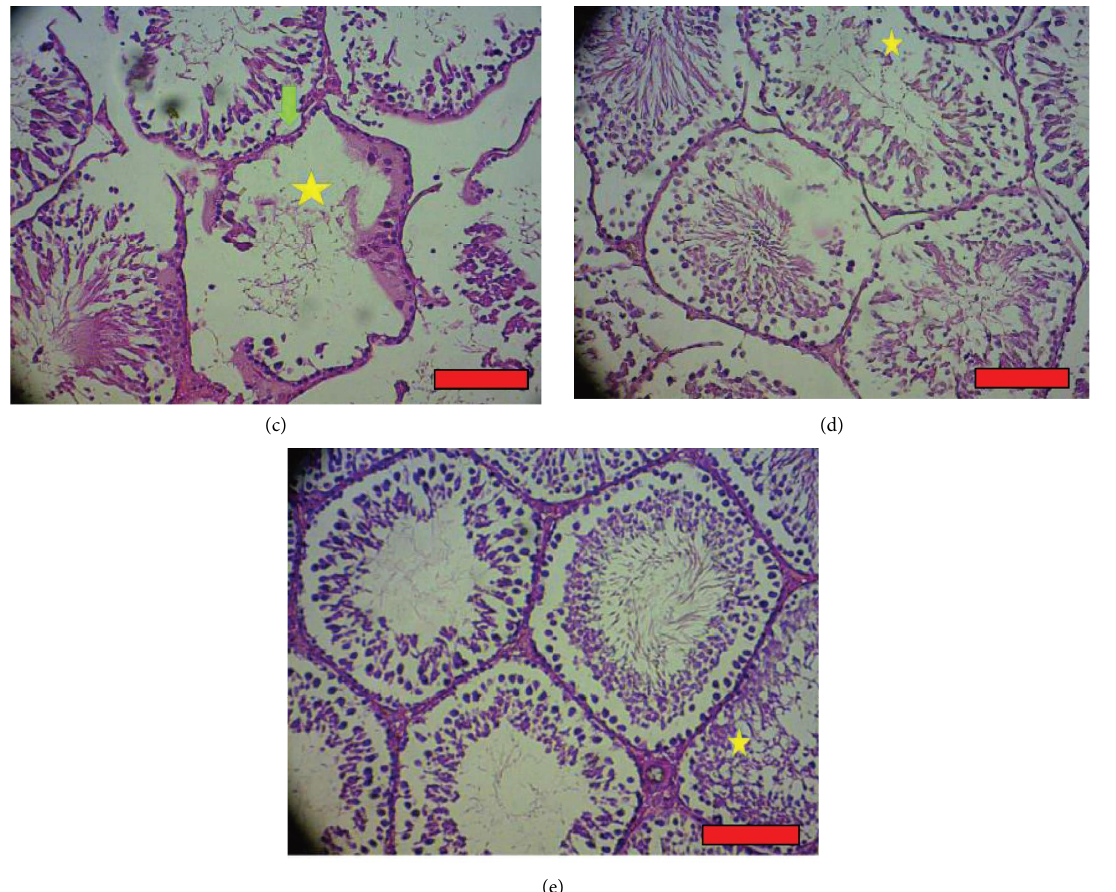
Figure 5: Results of histopathological changes in testicular tissues in different groups: yellow arrow � presence of tissue macrophage cell in seminiferous tubules. Star � destruction of seminiferous tubules and disruption of cellular order. Green arrow � folding of the base tube of the seminiferous tubules. Red line � scale bar (100 μ m). (a) Control group: H&E (100% magnification). (b) T1DM group: H&E (100% magnification). (c) Diabetes and silk group 200 mg: H&E (100% magnification). (d) Diabetes and silk group 400mg: H&E (100% mag- nification). (e) Diabetes and silk group 800mg: H&E (100%